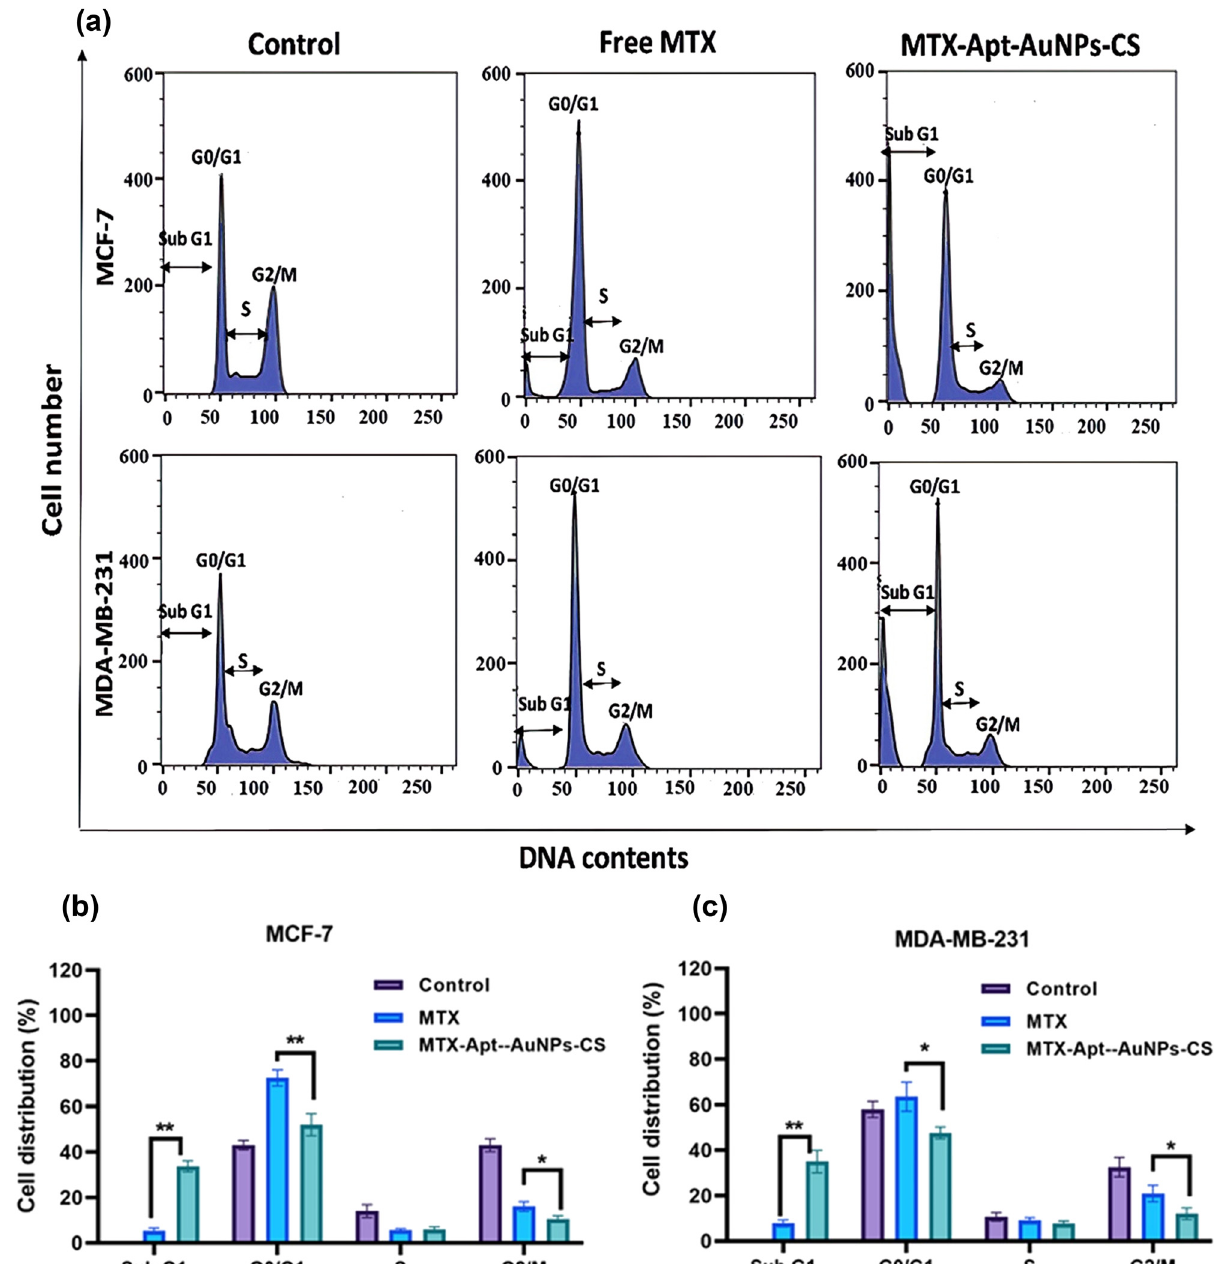
Figure 7: ( a ) Cell cycle distribution histograms of the target cells. Relative cell cycle distribution of Sub G1, Go/G1, S, and G2 phases in ( b ) MCF - 7 and ( c ) MDA - MB - 231. * p < 0.05 shows signi fi cant di ff